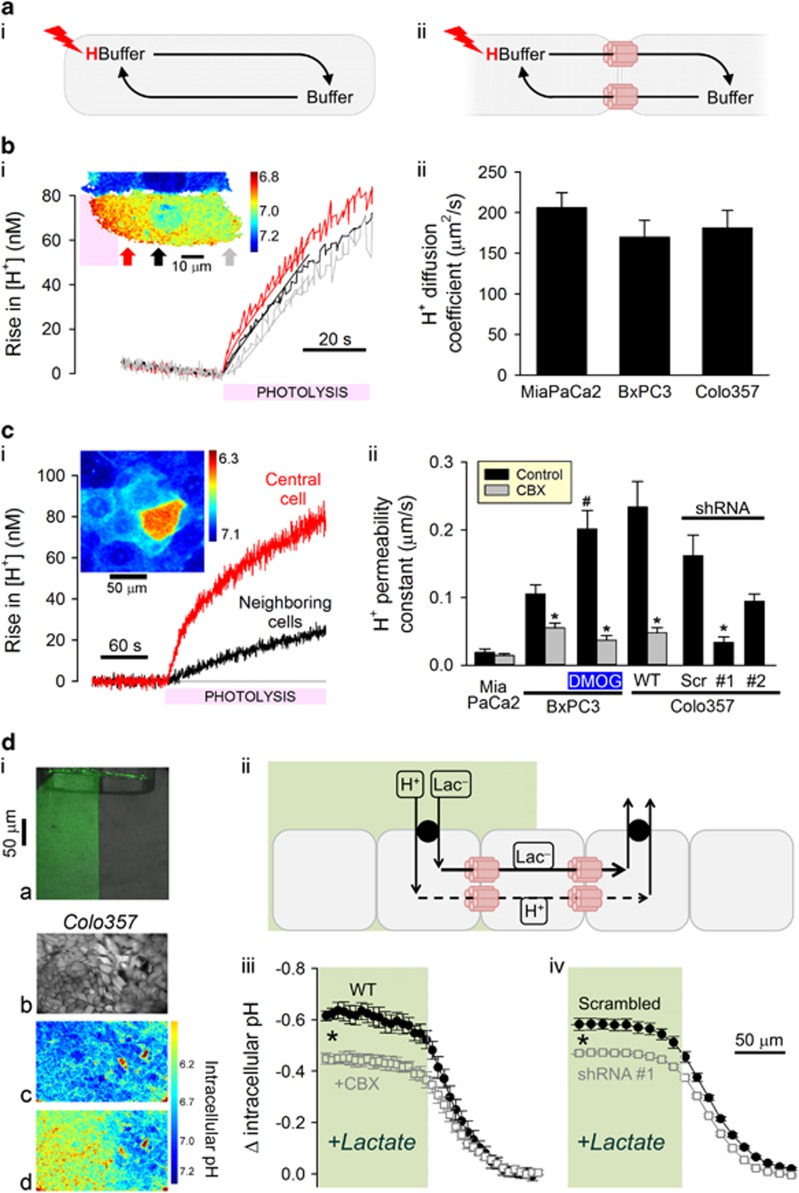
Junctional transmission of lactate and H+ ions. (a(i)) A source of H+ ions drives passive exchange of protonated and unprotonated buffers. Cytoplasmic H+ diffusivity probes buffer mobility in a cell. (ii) Cell-to-cell H+ permeability probes buffer transmission through gap junctions. (b(i)) Measuring H+ diffusion in a Colo357 cell, superfused in Hepes-buffered solution containing 1 mm NVA, the caged H+-compound. H+-uncaging (shaded region) produces a H+ microdomain that spreads diffusively in cytoplasm. Time courses of [H+] in three regions of interest (indicated by arrows) best-fitted with diffusion equation. (ii) Mean±s.e.m. (N=12, 15, 10). (c(i)) Measuring junctional H+ permeability between Colo357 cells. H+ ions were uncaged from 0.5 mm NVA in a central cell and time courses of [H+] in the central and neighboring cells derive junctional H+ permeability. (ii) Mean±s.e.m. (N=10, 11, 12, 10, 14, 12, 18, 10, 12, 14, 10). Experiments repeated in presence of carbenoxolone (CBX; 100 μm) and on GJA1 knockdown cells. Unpaired t-test *P<0.01 (effect of CBX), #P<0.02 (effect of DMOG). (d(i-a)) Regional exposure of a monolayer to 40 mm lactate-containing Hepes-buffered solution using a double-barrelled micropipette. For illustrative purposes, one microstream was labelled with 30 μm fluorescein; (b) fluorescence of cSNARF1-loaded monolayer; (c) pHi before and (d) during regional exposure to lactate. (ii) Rapid junctional lactate transmission dissipates syncytial [lactate]i gradient and permits further MCT-dependent H+-lactate entry into cells under the lactate-containing microstream (shaded green). (iii) Steady-state intracellular pH across monolayer of wild-type Colo357 cells measured after 2 min of regional exposure to lactate, minus intracellular pH under resting conditions. Experiment repeated in presence of CBX (100 μm). Mean±s.e.m. (N=7 WT, 10 CBX). (iv) Measurements on Colo357 cells transduced with shRNA #1 (knockdown) or scrambled construct. Mean±s.e.m. (N=5 WT, 5 CBX). ANOVA *P<0.05 for effect of CBX and for the effect of knockdown.